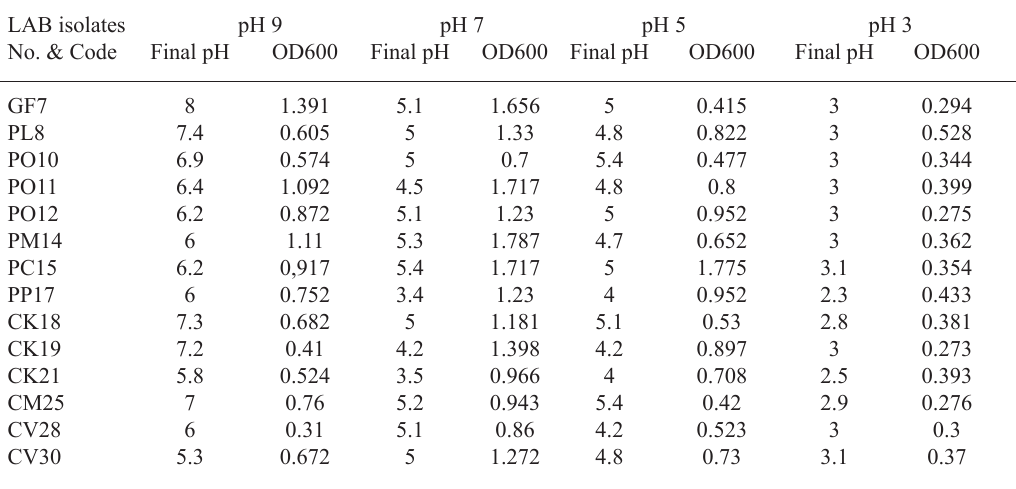
Table 1. Growth of LAB isolates at different initial pH values and their final pH values LAB isolates